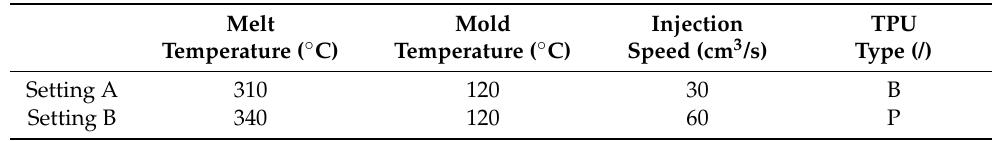
Figure 10. Smart@Surface demonstrator shown prior to overmolding ( a ) and after overmolding us- ing two different sets of injection molding parameters ( b , c ). A summary of the used molding parameters is given in Table 8. Table 8. Summary table with molding parameters used to manufacture the Smart@Surface demon- strators shown in Figure 10b,c.